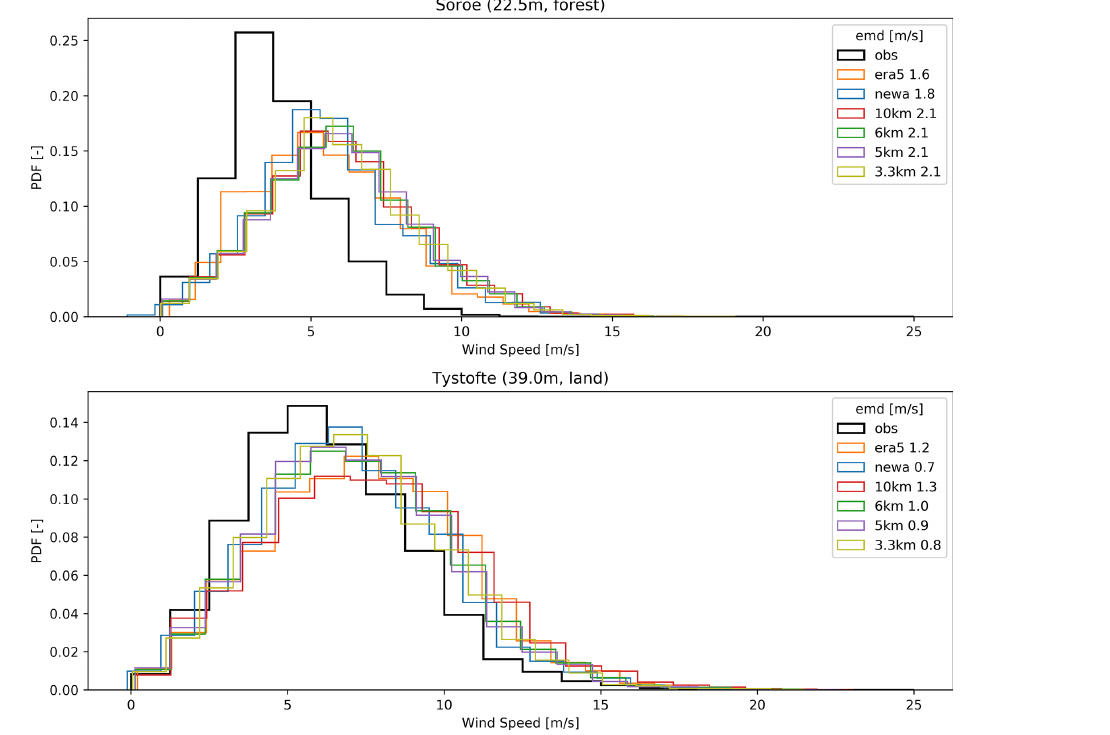
Figure 7. Probability density function (PDF) and Earth mover’s distance (EMD) between simulations and measurements (OBS) for the various experiments in Table 1 and reanalyses and two inland sites measured at lower heights.